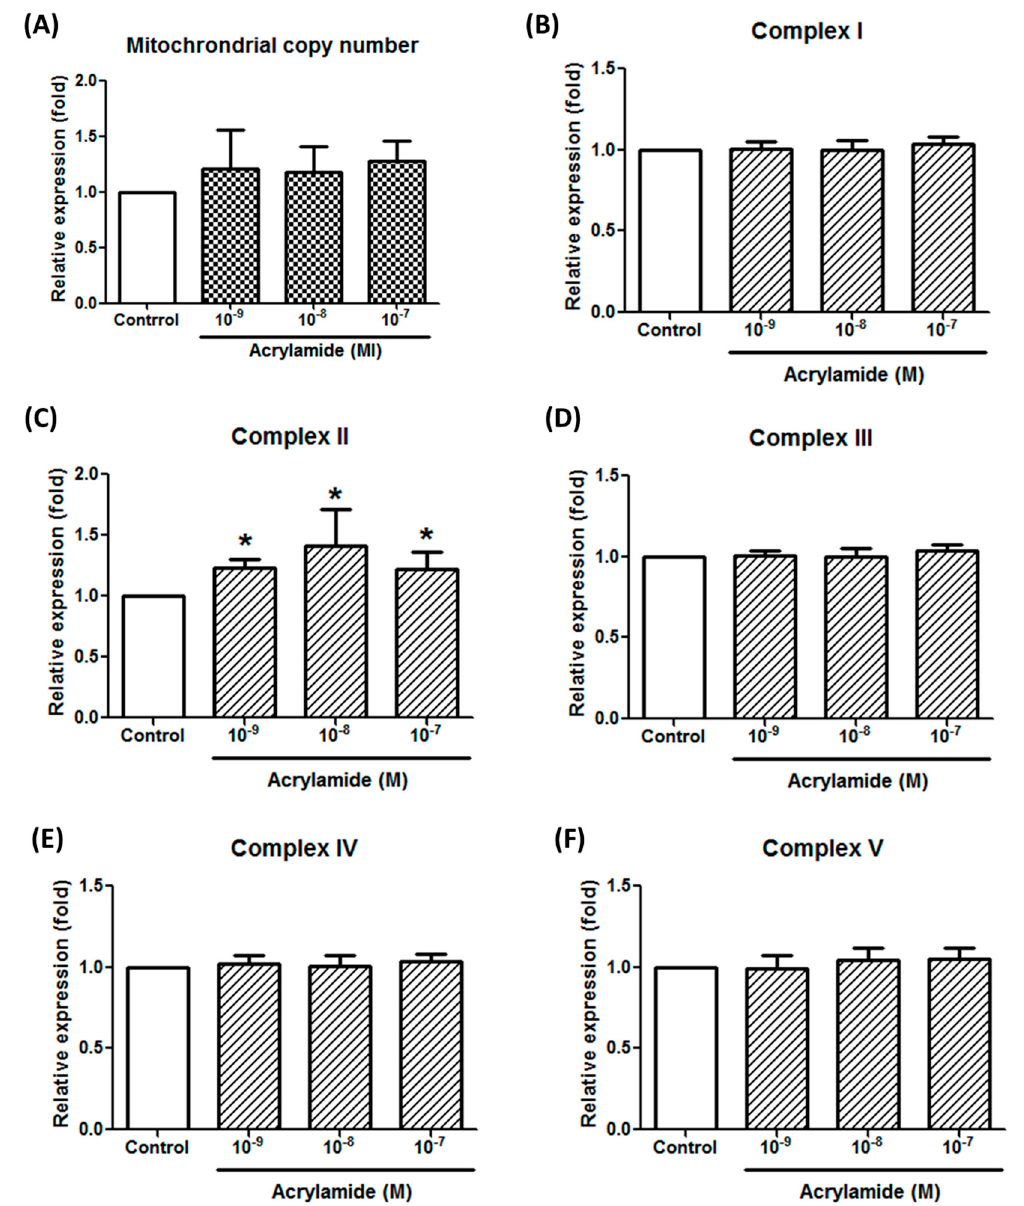
Figure 2. Acrylamide-induced respiratory chain complex II gene expression in THP-1 cells. ( A ) Mitochondrial copy number in THP-1 cells were calculated by detecting the ratio of mitochondria-specific ND-1 gene expression and chromosome- specific 18S-rRNA gene expression by real-time PCR. ( B ) The effects of acrylamide on mitochondrial respiratory chain complex I specific gene ND-1 expression were detected by real-time PCR. ( C – F ) The effects of acrylamide on the expressions of mitochondrial respiratory chain complex II specific gene SHDA , complex III gene CYTB , complex IV gene COX-1 and complex V gene ATP6 , were detected by real-time PCR. Among detected mitochondrial complex genes, the complex II specific gene SHDA was significantly increased by acrylamide treatments. * p < 0.05 by the Kruskal-Wallis test; n = 6, means ± SD.